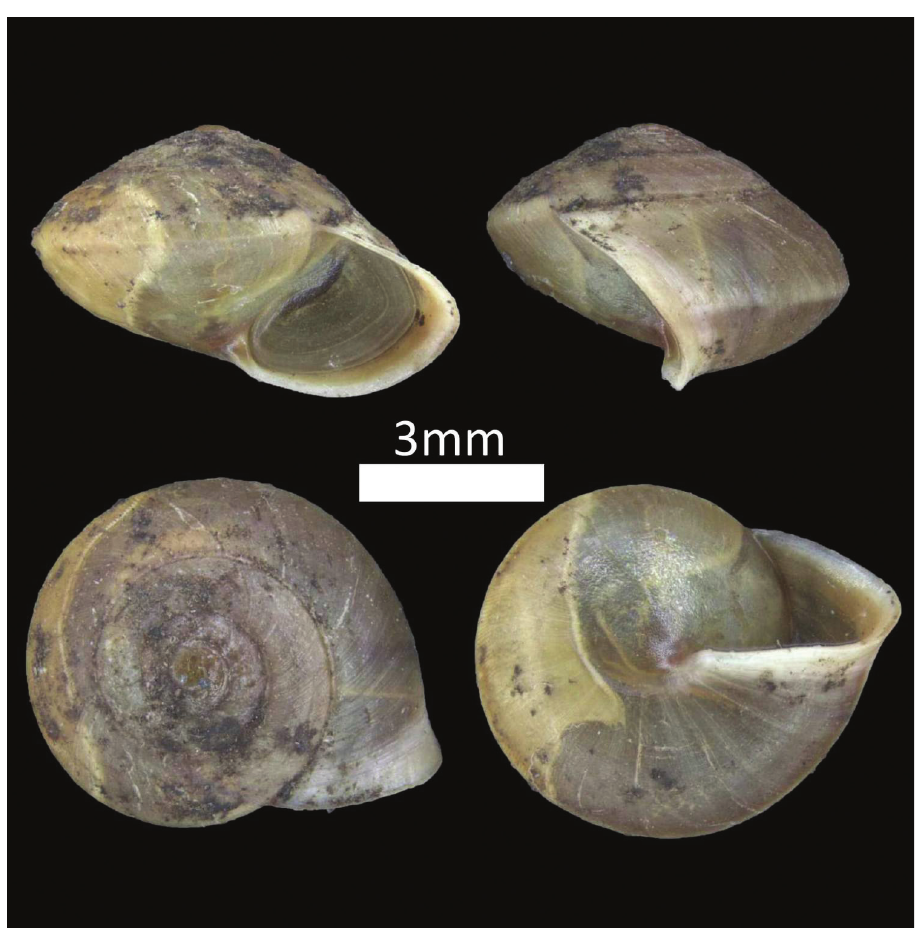
Figure 7. Family Helicinidae. Aphanoconia usukanensis (BOR/MOL 7200).